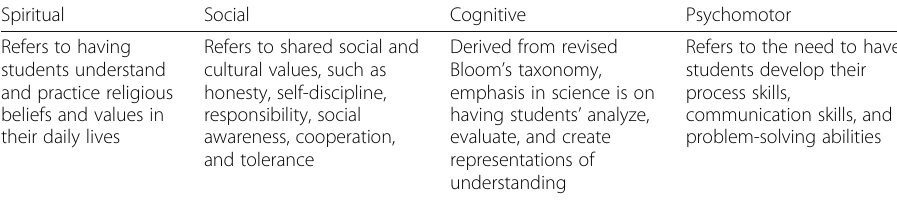
Refers to the need to have students develop their process skills, communication skills, and problem-solving abilities